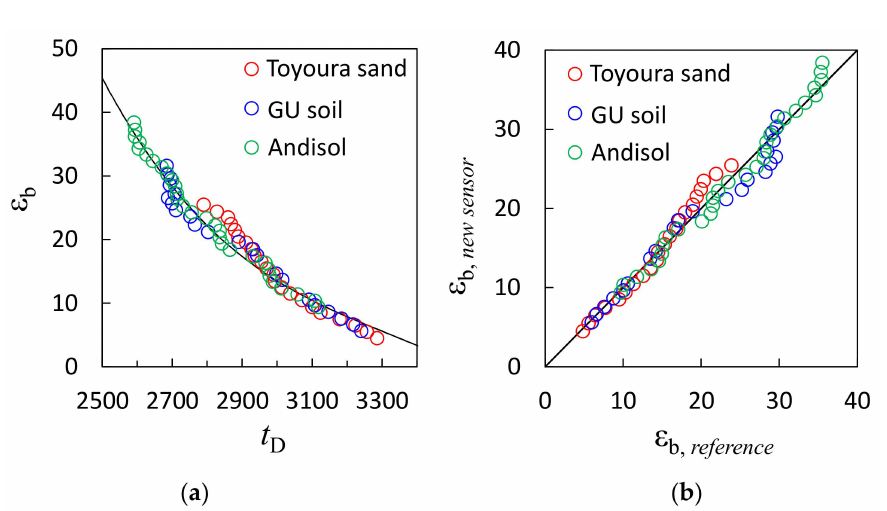
Figure 3. ( a ) Relationship between dielectric constant ( ε b ) measured with a reference sensor and t D measured with the new sensor, and ( b ) comparison between ε b measured with the reference sensor ( ε b , reference ) and the new sensor ( ε b , new sensor ). The different colored plots represent the different soil types, i.e., Toyoura sand, Gifu University experimental field soil (GU soil), and